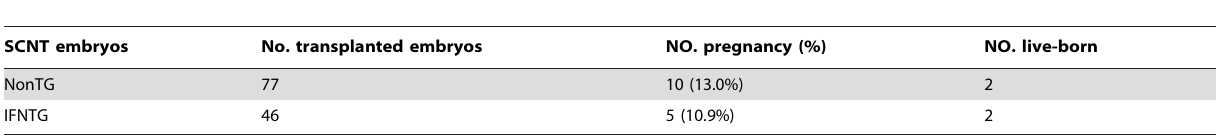
Table 3. Pregnancies of recipients of transgenic SCNT embryos and non-transgenic SCNT embryos.